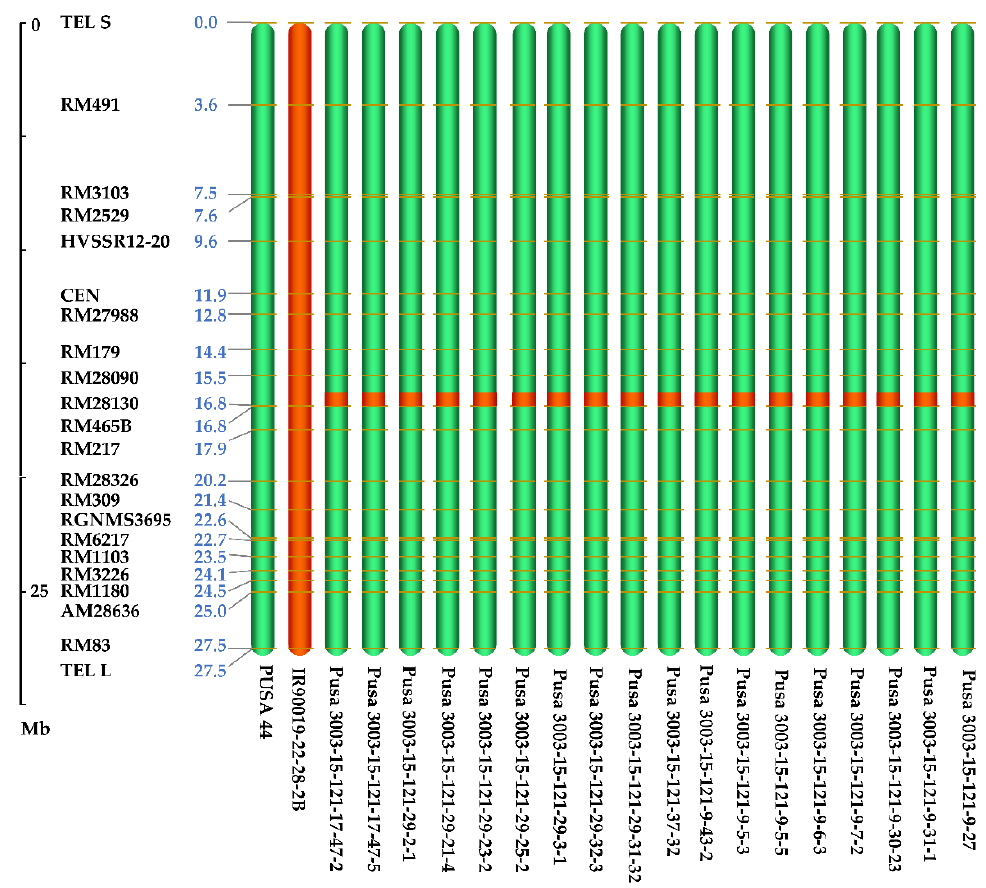
Figure 3. Graphical genotype of Chromosome 12, the carrier chromosome of the QTL, qDTY12.1 among the Pusa44 qDTY12.1 -NILs. 29 NILs showed complete recovery of Chromosome 12, based on the polymorphic flanking markers of the QTL.